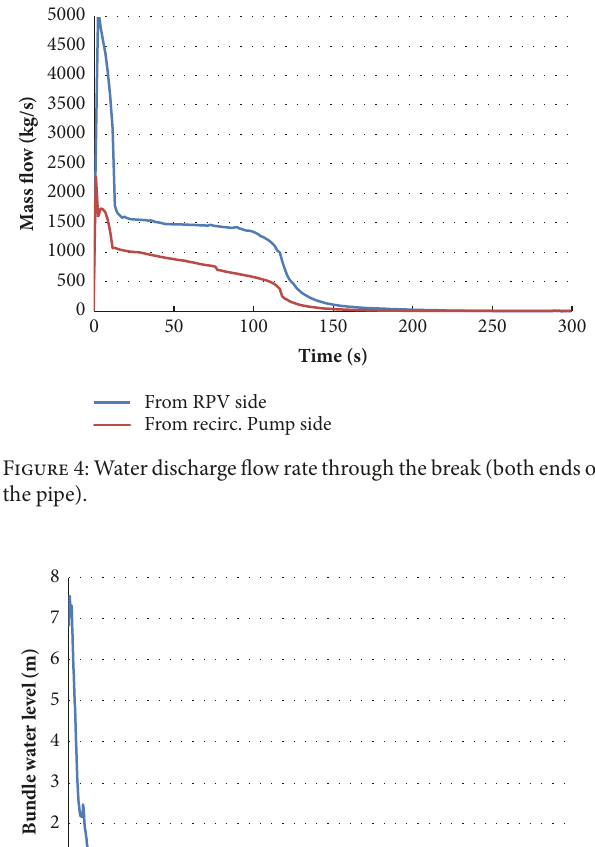
Figure 7: Peak cladding temperature of the